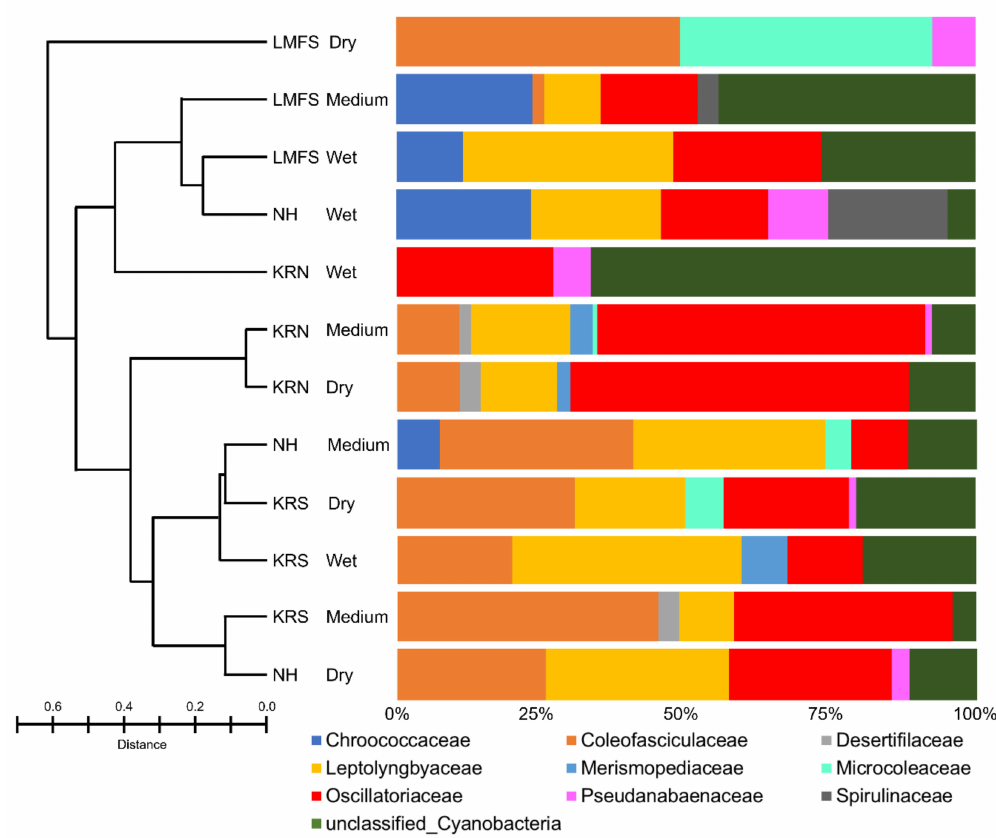
Figure 6. Bar plot showing the relative abundance of cyanobacterial amplified sequences separated by regions and conditions. Abundances were normalized to the total number of sequences. Bray–Curtis dissimilarity index is shown on the